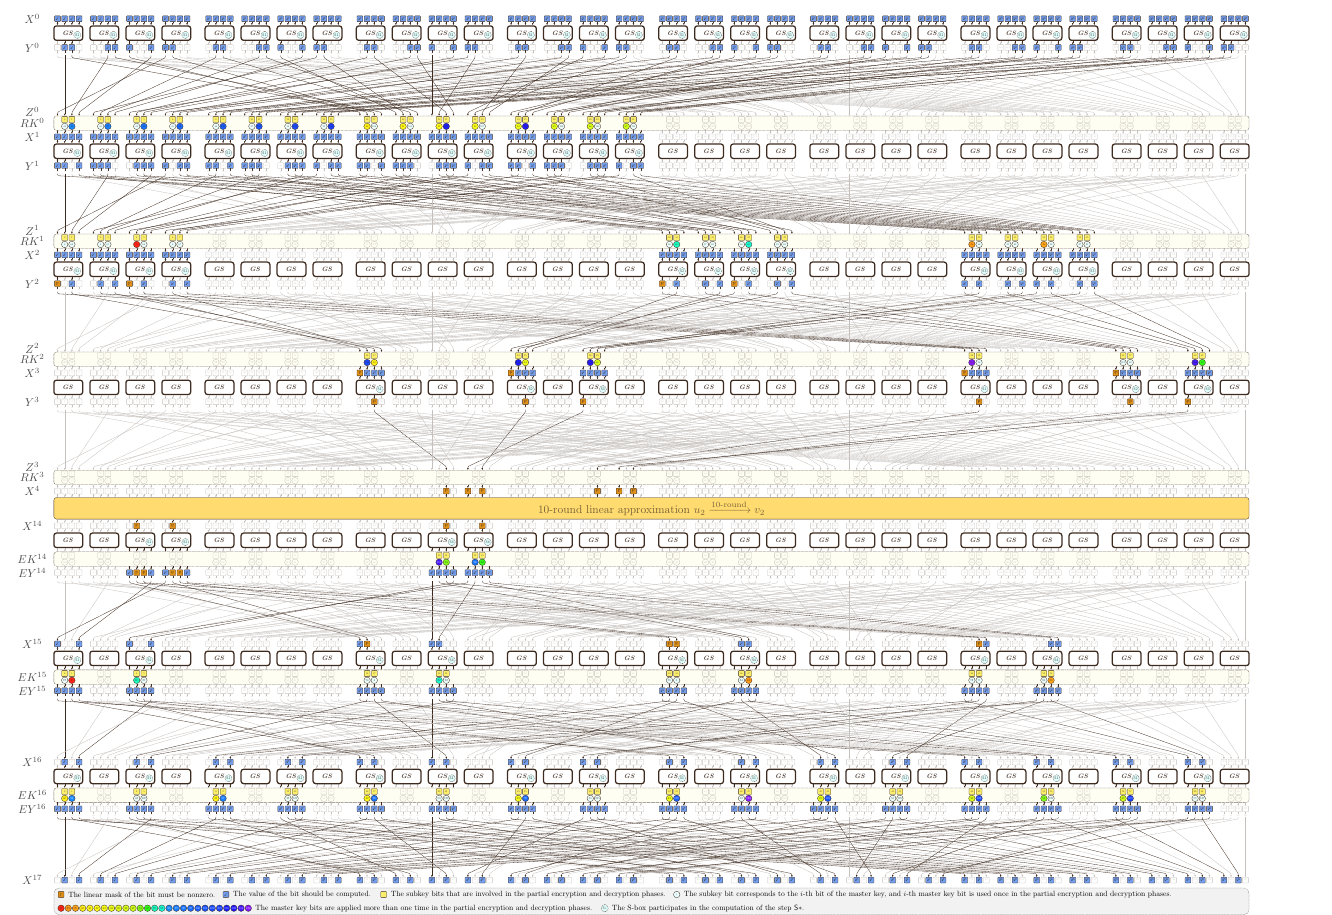
Figure 8: Key-recovery attack on 17-round GIFT-128 in SUNDAE-GIFT